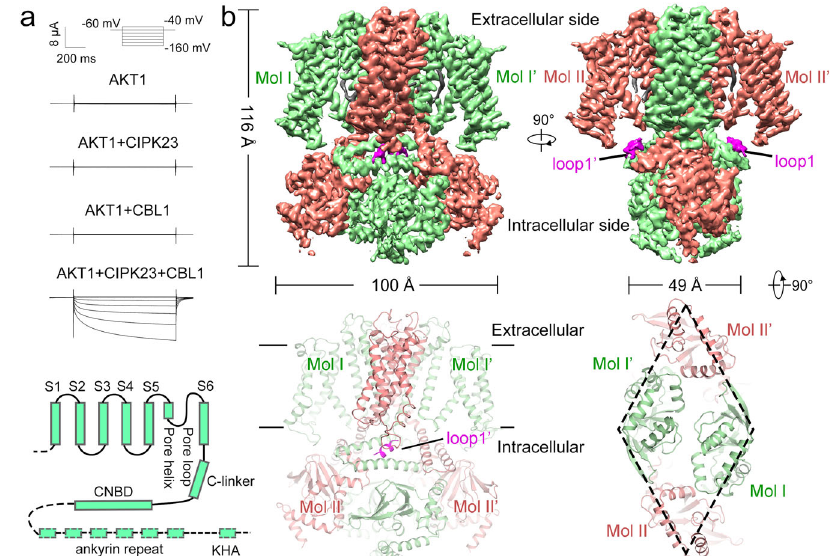
Fig. 1 | Functional validation and structural determination of the potassium channel AKT1 from Arabidopsis . a Whole-cell current trace of the AKT1 recorded in Xenopus oocytes. AKT1-mediated inward currents is dependent on the presence ofbothCIPK23andCBL1.AdiagramdepictingthemajordomainsinaAKT1subunit isshown. b TheatomicstructureofAKT1exhibits2-foldsymmetryviewedfromthe